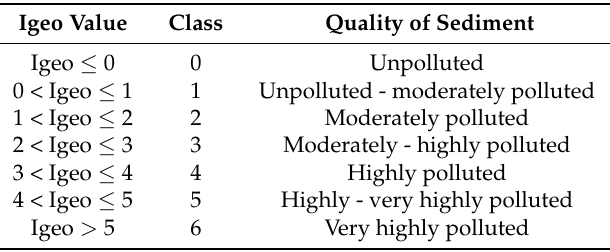
Table 1. Classification of Geo-accumulation index